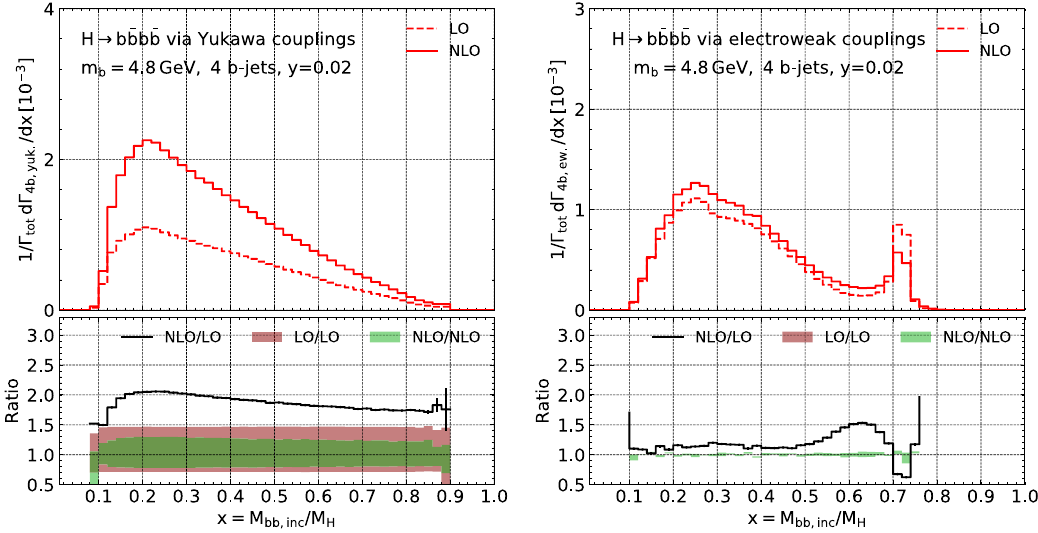
Figure 13 . Similar to figure 7 for distribution as a function of the inclusive invariant mass of all b -jet